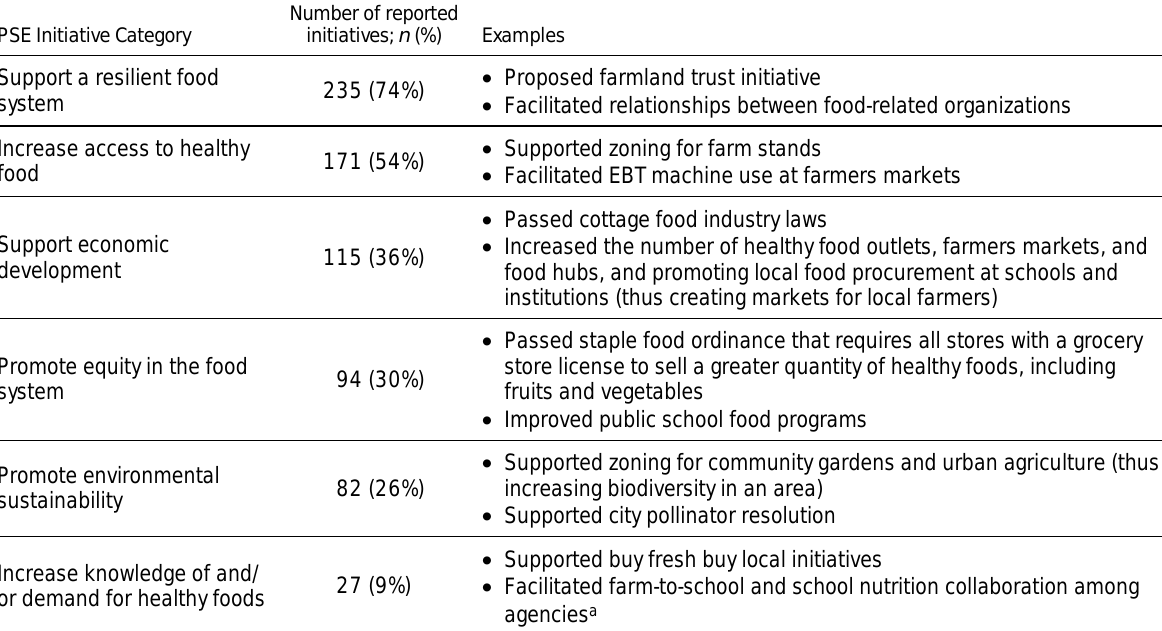
Table 3. Potential Impacts of Policy, Systems, and Environment Initiatives ( N =317) Reported by Members of 66 Food Policy Councils in